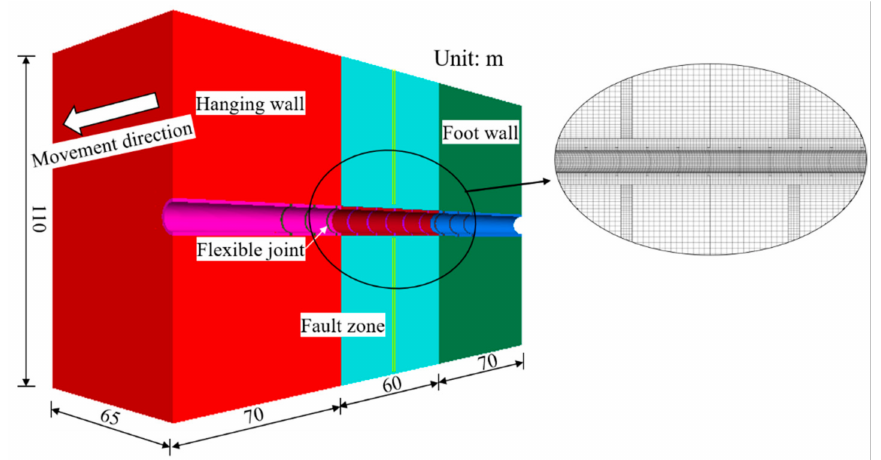
Figure 18. Calculation